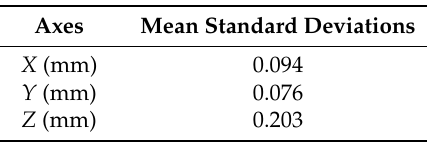
Table 3. Mean standard deviations of the 3D point coordinate determinations.